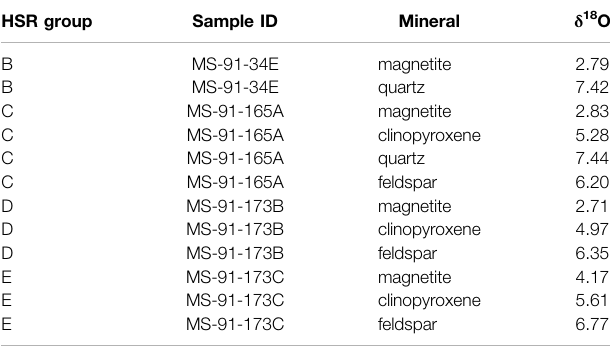
TABLE 4 | Oxygen isotope analysis